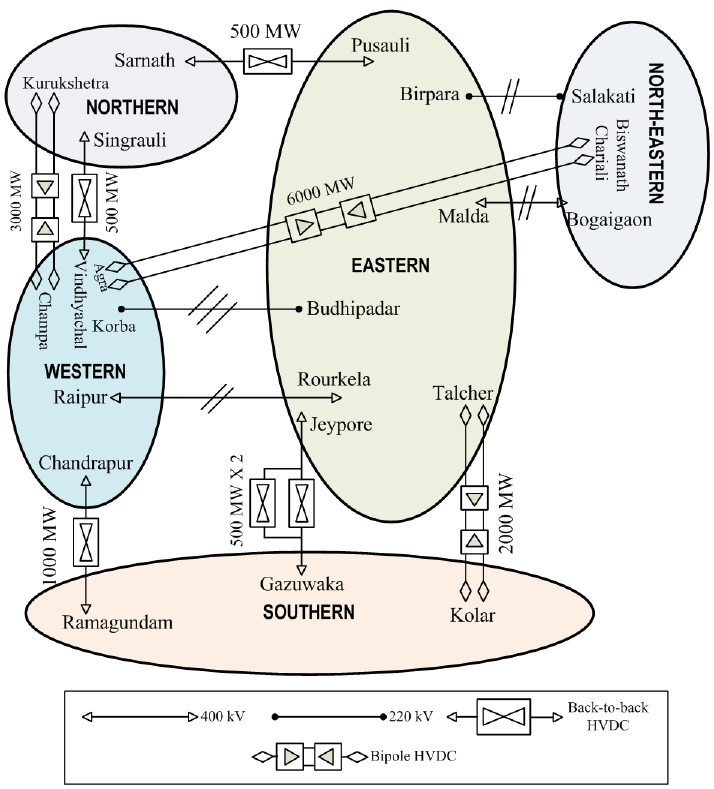
Figure 8. Some inter-regional grid interconnections in India